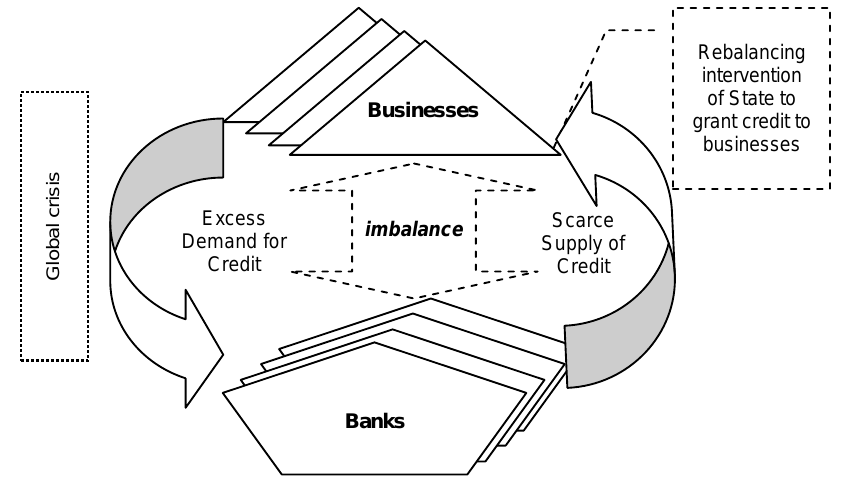
Figure 2: Relationship Between Demand and Supply in Recourse to the Credit